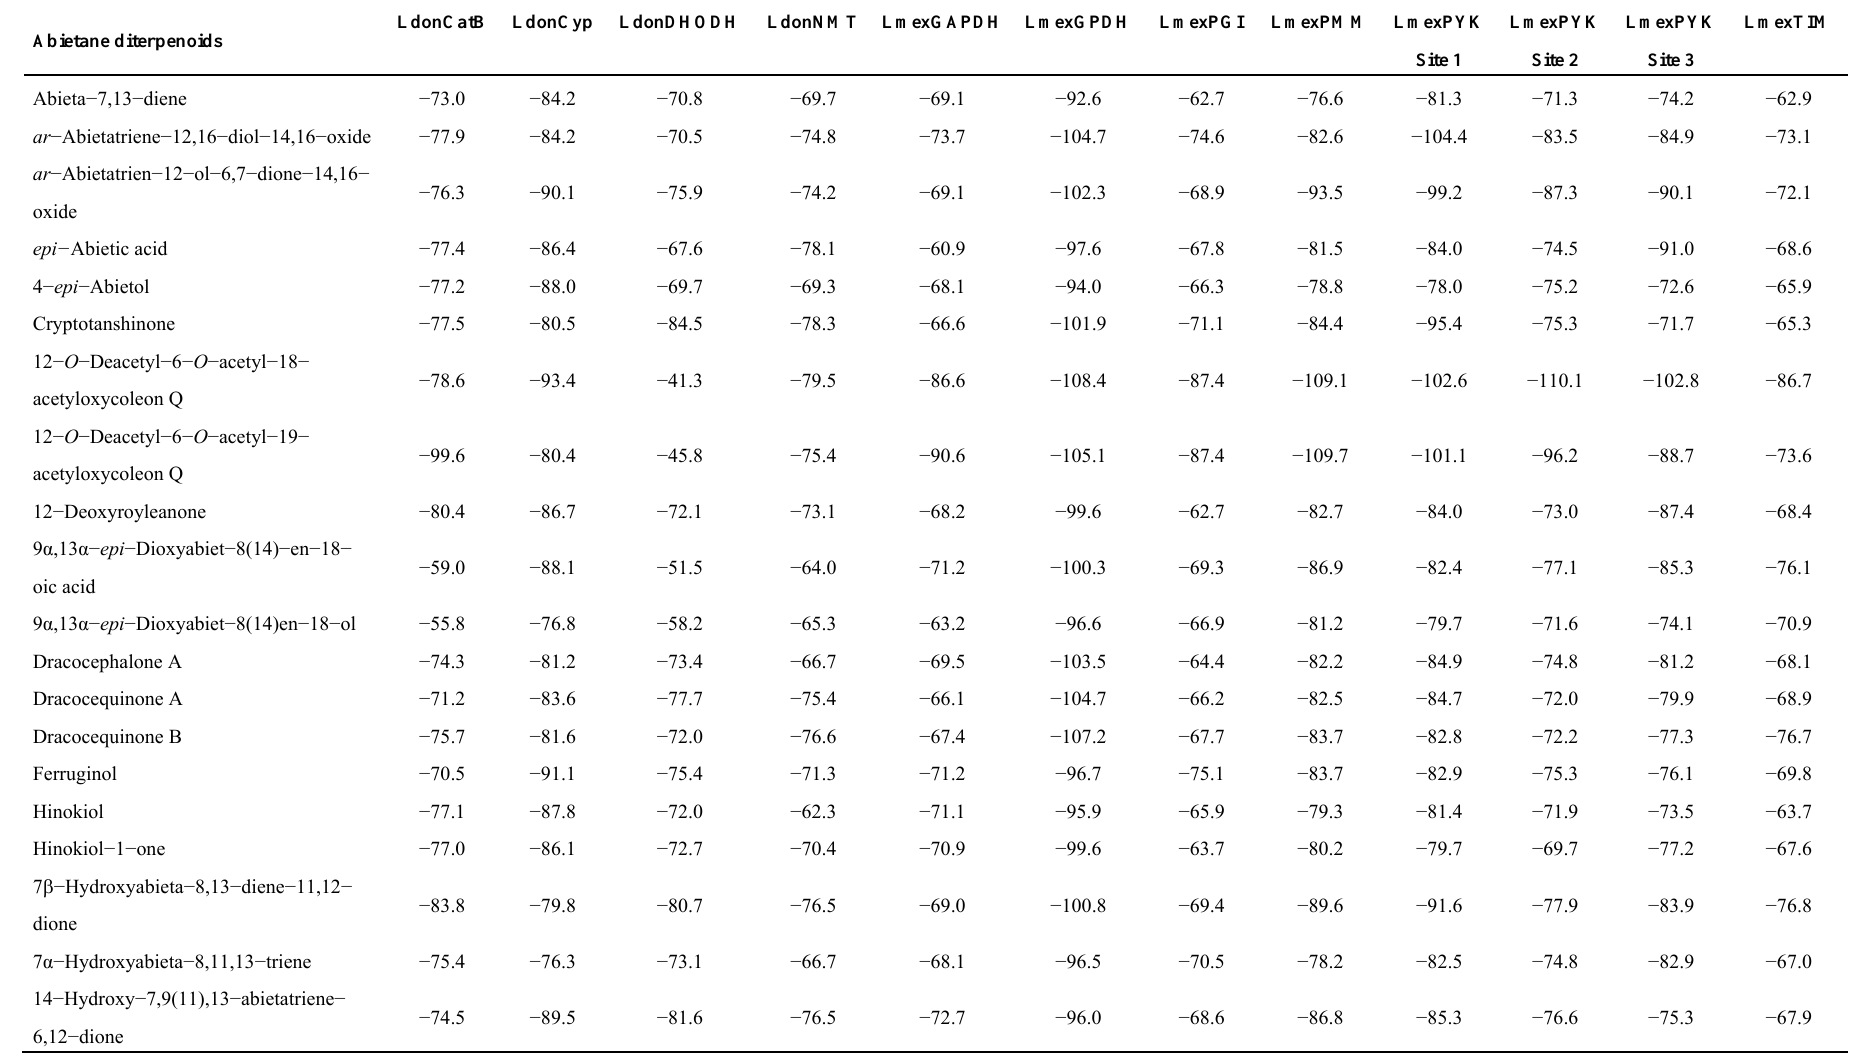
Table 17. MolDock docking energies (kJ/mol) of abietane diterpenoids with Leishmania donovani and L. mexicana protein targets. LdonCatB LdonCyp LdonDHODH LdonNMT LmexGAPDH Abietane diterpenoids